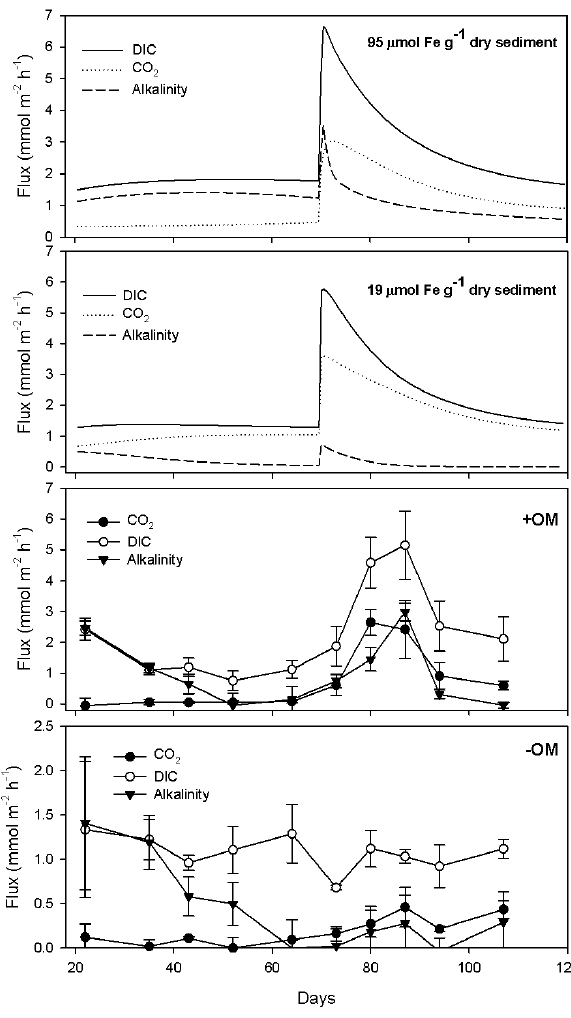
Fig. 2. Simulated mean fluxes of CO 2 during exposure (CO 2 ), dissolved inorganic carbon (DIC) and alkalinity during inundation in the computer simulation with 95 and 19µmolFeg − 1 sediment ( d/w ) and laboratory core incubation fluxes with (+OM) and with- out ( − OM) added organic matter. Error bars are standard deviations across 10